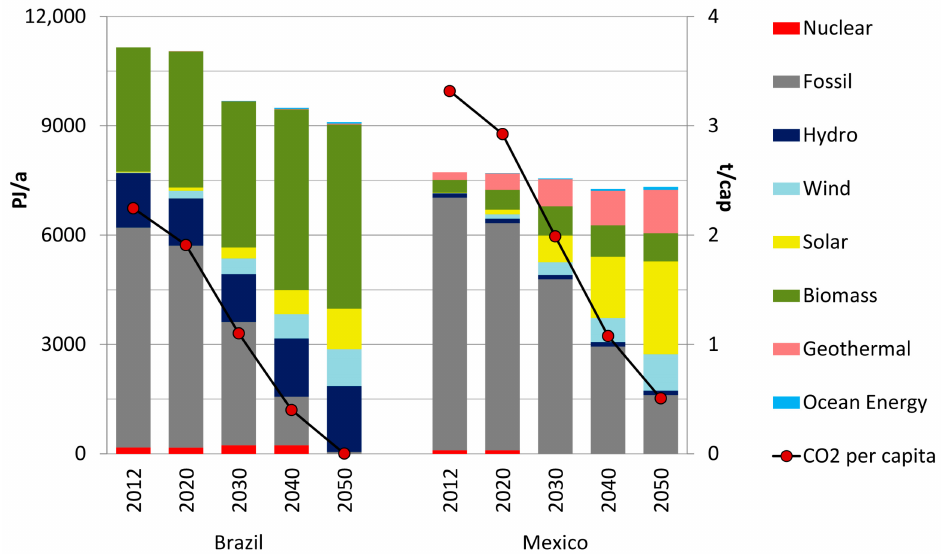
Figure 7. Primary energy supply and per capita CO 2 emissions in Brazil and Mexico in